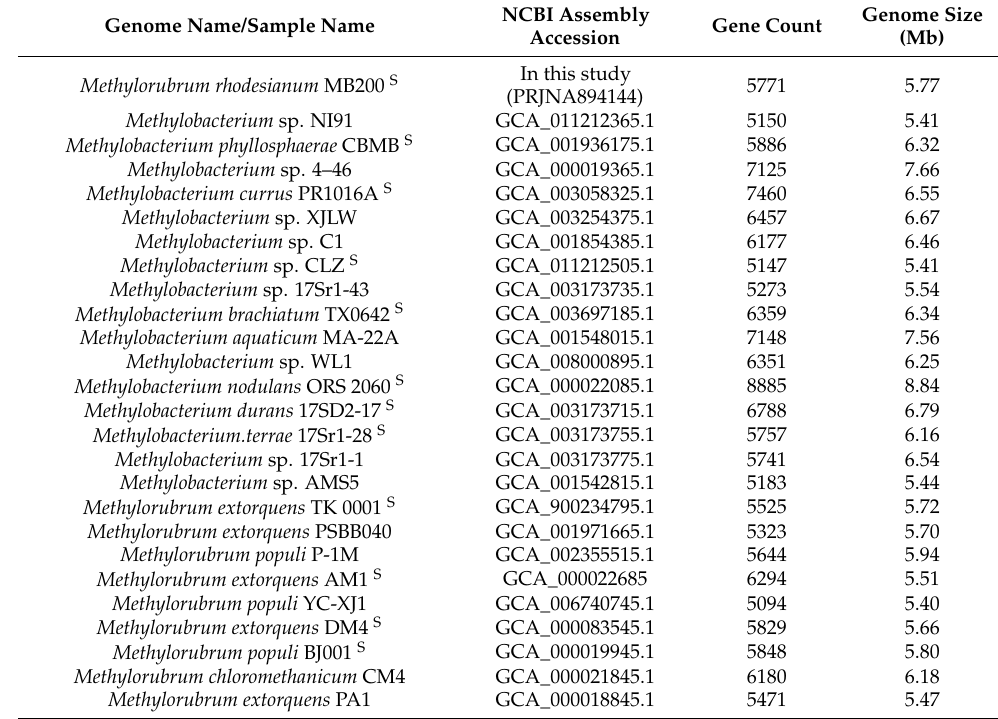
Table 1. The details of samples used for comparative genomic